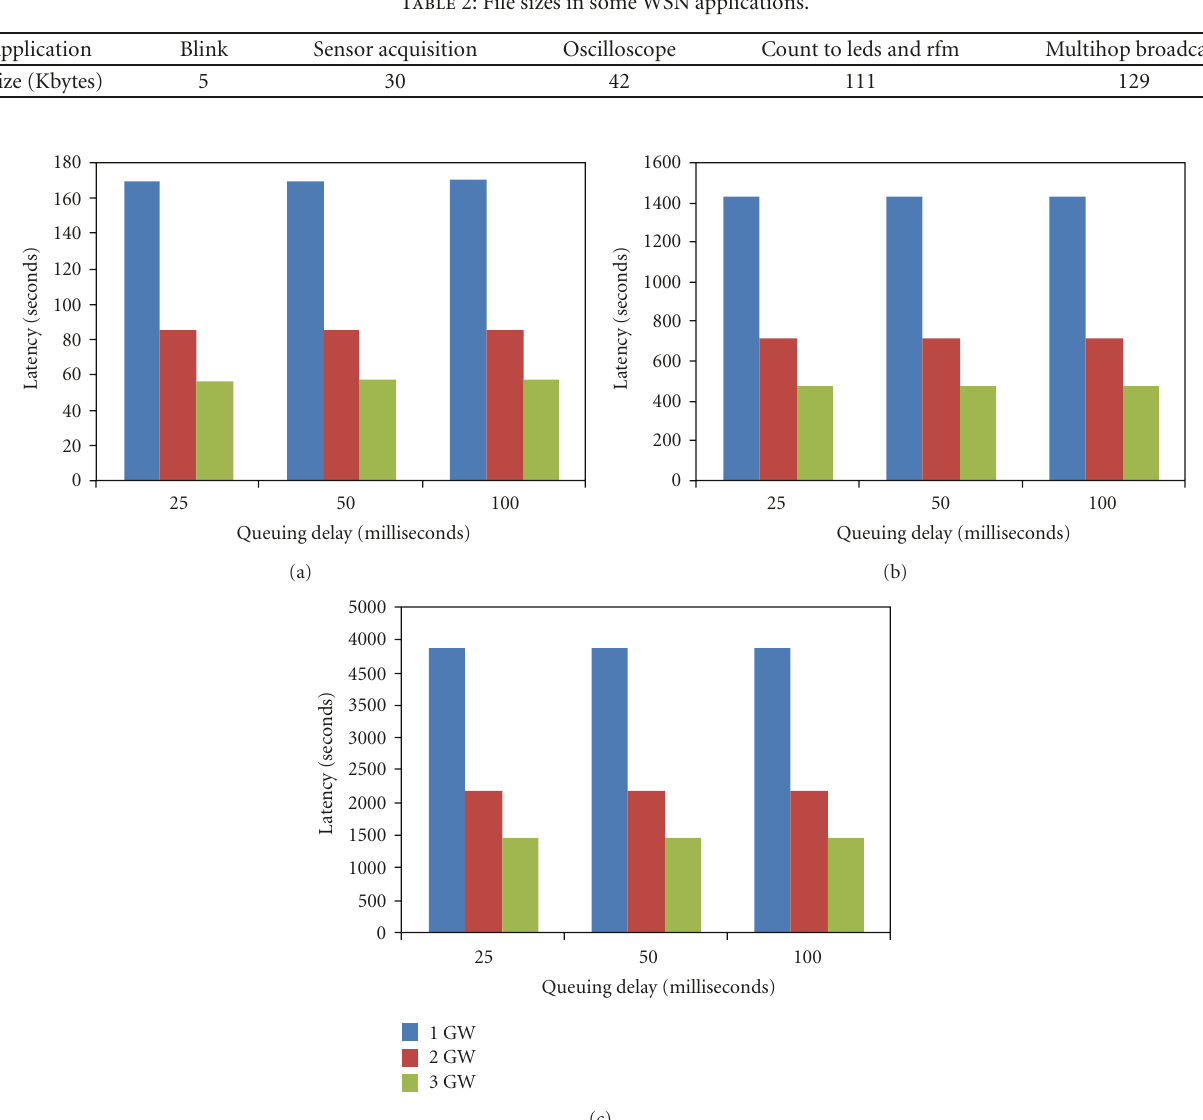
Table 2: File sizes in some WSN applications.